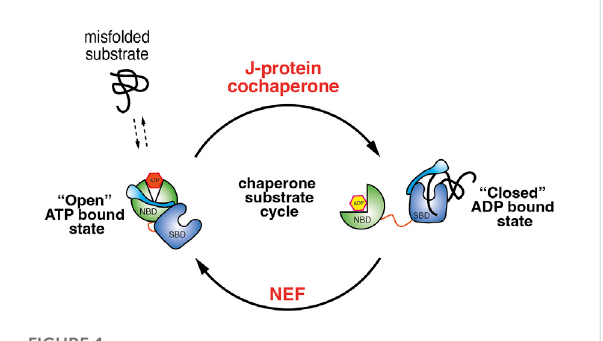
Illustration depicting the Hsp70 ATPase cycle. When Hsp70 is bound with ATP it adopts a conformation that positions the NBD and SBD in proximity. This facilitates the movement of lid, exposing the substrate binding pocket, which enables fast substrate binding and release and works together with J-domain co-chaperones that recruits misfolded protein to Hsp70. The association of J-domain co- chaperone stimulates ATP hydrolysis and transition to ADP bound conformation in which the lid now closes over the SBD trapping the substrate. NEF mediate the exchange of ADP for ATP and allows transition back to the “ open ” ATP bound Hsp70